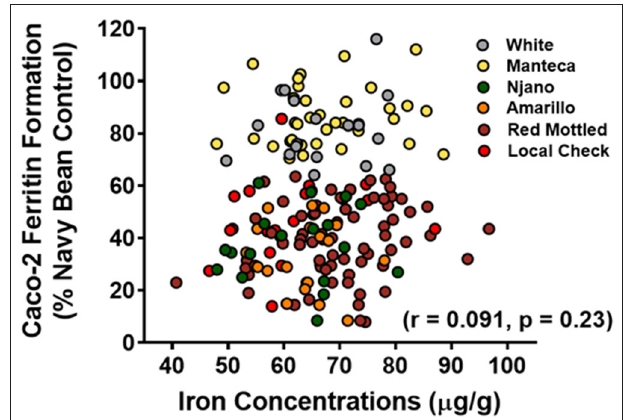
FIGURE 5 | Scatter plots illustrating the relationship between cooked seed iron and iron bioavailability of the ten genotypes grown in nine locations across three agro-ecological zones in Uganda. Each value represents the mean of two field replicates per genotype from each location for field season 2015 and 2016 ( n = 179). Adapted from Katuuramu et al.